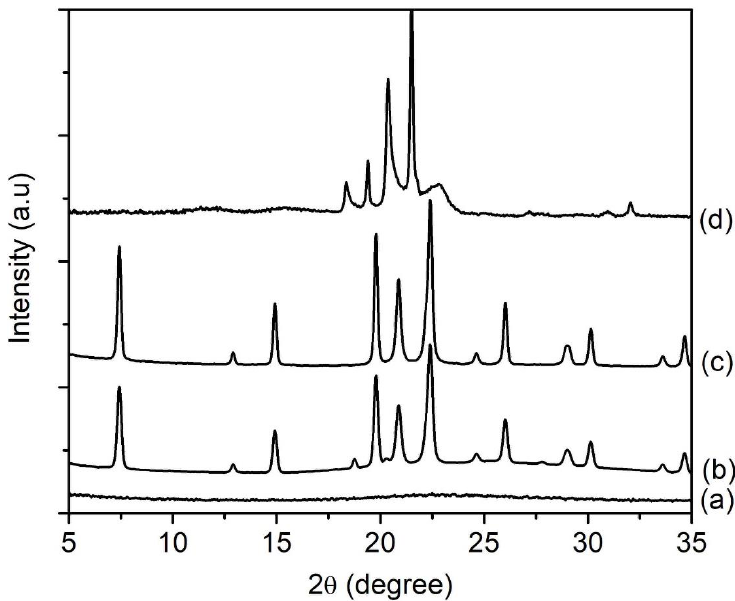
Figure 11. XRD patterns of ( a ) SH18, ( b ) SH19, ( c ) SH4 and ( d ) SH20 prepared with a molar composition of 1Al 2 O 3 :2.5P 2 O 5 :2.5[bzmIm] 2 O:180H 2 O:0.47SiO 2 . The samples were heated at 100, 120, 150 and 200 °C for 10 h, respectively.